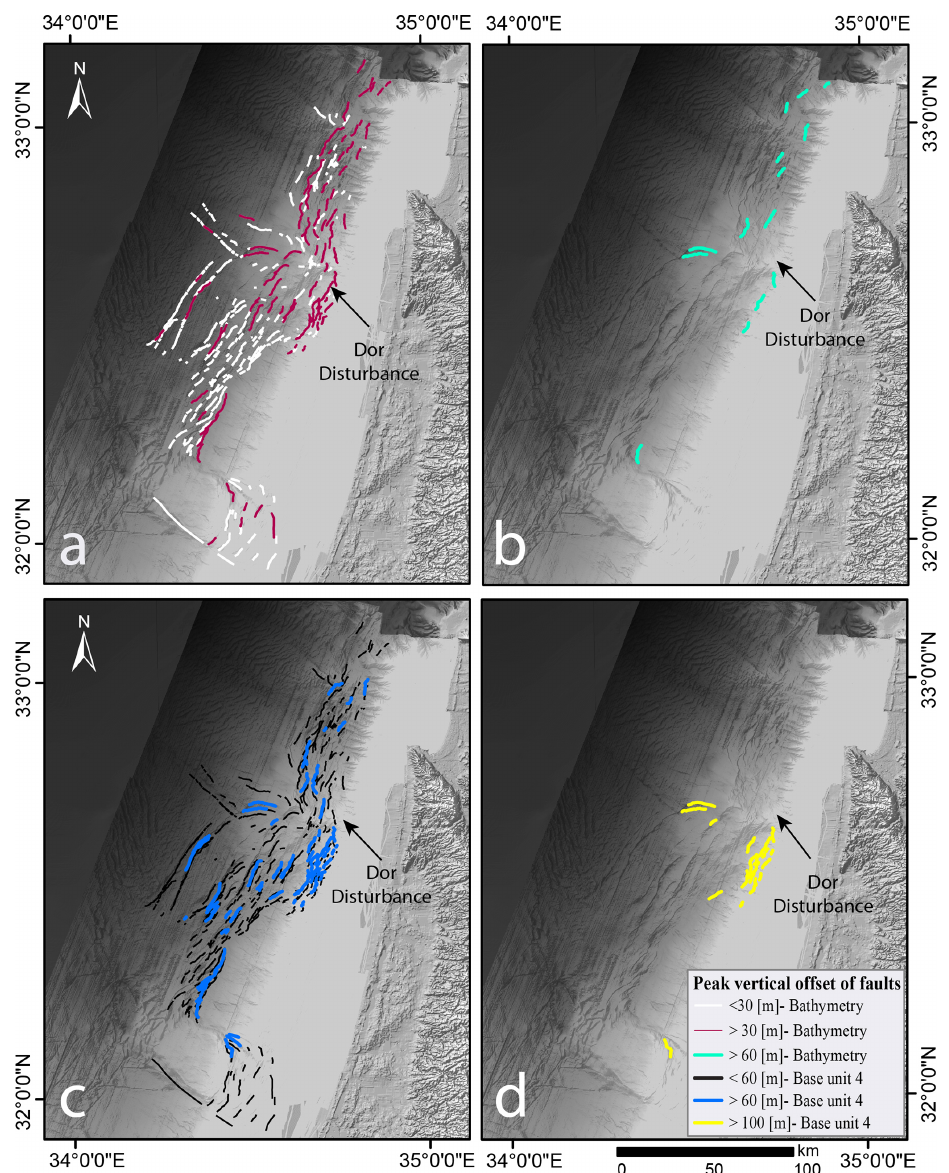
Figure 6. Fault classification by vertical throw after assigning each fault segment a single value, representing the maximum vertical displace- ment measured anywhere along it. (a) Faults forming seabed scarps smaller (white) and higher (red) than 30m. (b) Faults forming seabed scarps larger than 60m (turquoise). (c) Faults displacing base unit 4 by more than 60m (blue) and smaller than 60m (black). (d) Faults dis- placing base unit 4 by more than 100m (yellow). Note that faults with the largest vertical throw are concentrated around the Dor disturbance. Background in all maps is shaded relief of bathymetry (Tibor et al.,